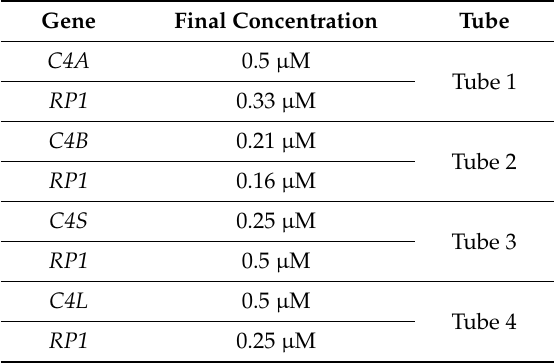
Table 3. Primer pairs for high resolution melting (HRM)-PCR / gene ratio analysis copy enumeration (GRACE)-PCR assay. Gene, final concentration of each primer required for HRM-PCR /